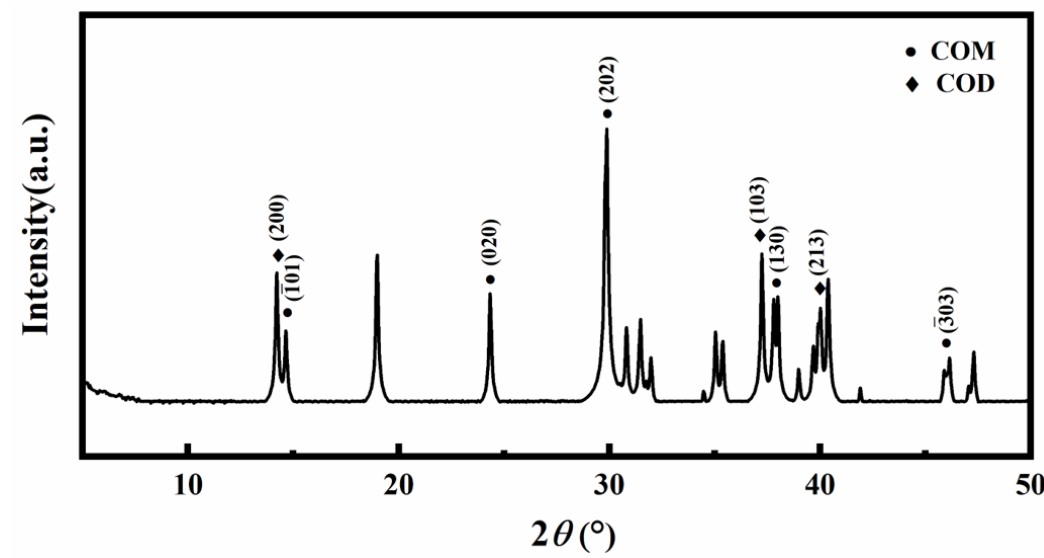
Figure 2. XRD diffraction diagrams of crystals. ● : COM, ◆ : COD.